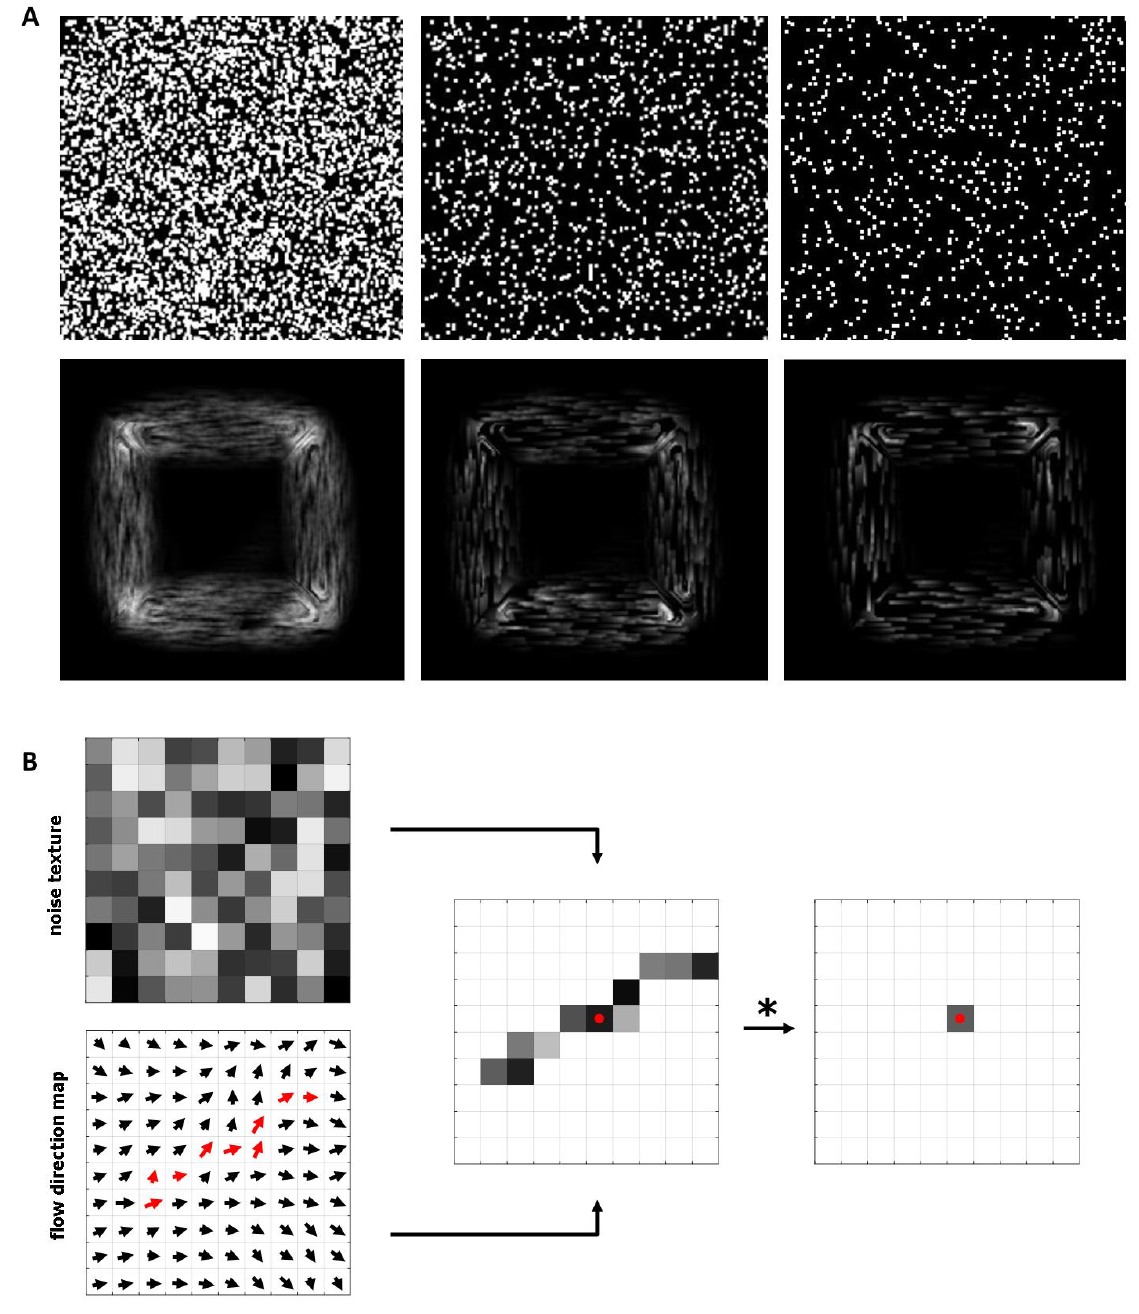
Figure 5. A) Visualization of the flow direction map for the square scanpath dataset using the oriented line integral convolution algorithm. In the top row, three input textures of decreasing density are shown. In the bottom row, the corresponding OLIC visualizations are depicted. B) For each pixel, a noise tex- ture is filtered using a convolutional kernel according to the flow direction